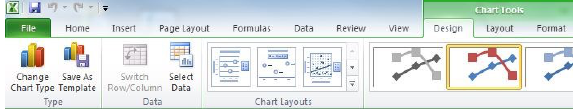
Fig. 7 . Chart Tools bar with a button Select Data